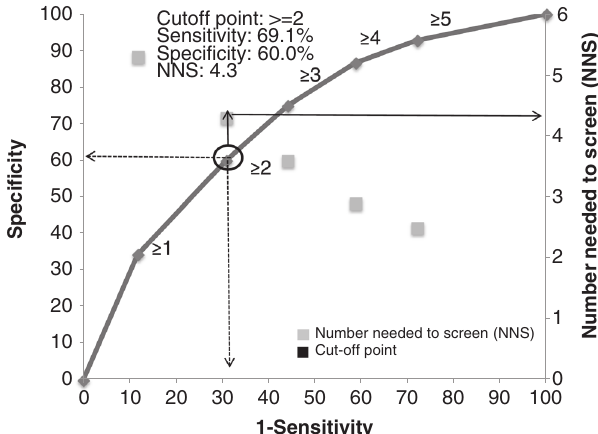
Fig. 3 AUC analysis for different cutoff-points of the SCSQ for the population-based BOLD sample